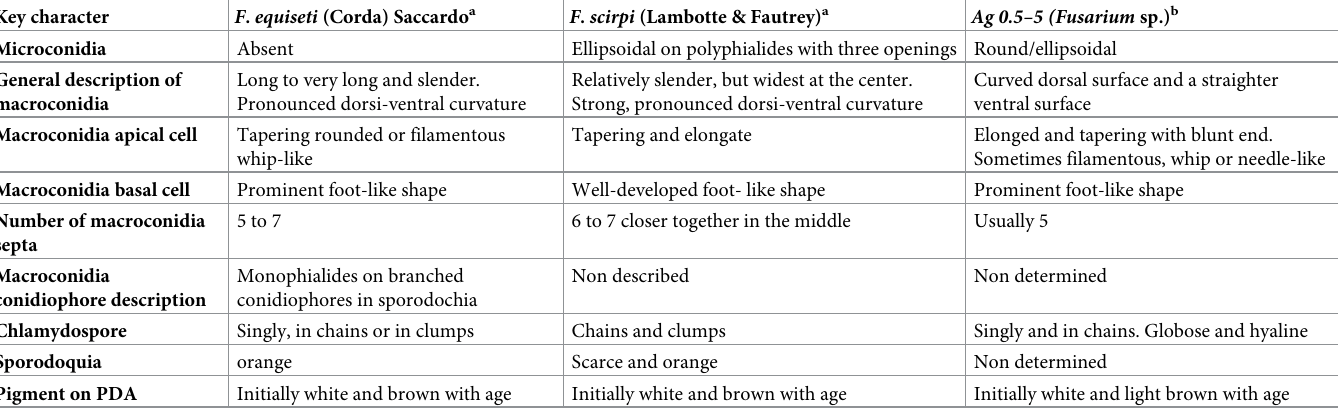
Table 1. Morphological key characters of Fusarium equiseti (Corda) Saccardo, Fusarium scirpi (Lambotte & Fautrey) and Fusarium sp.